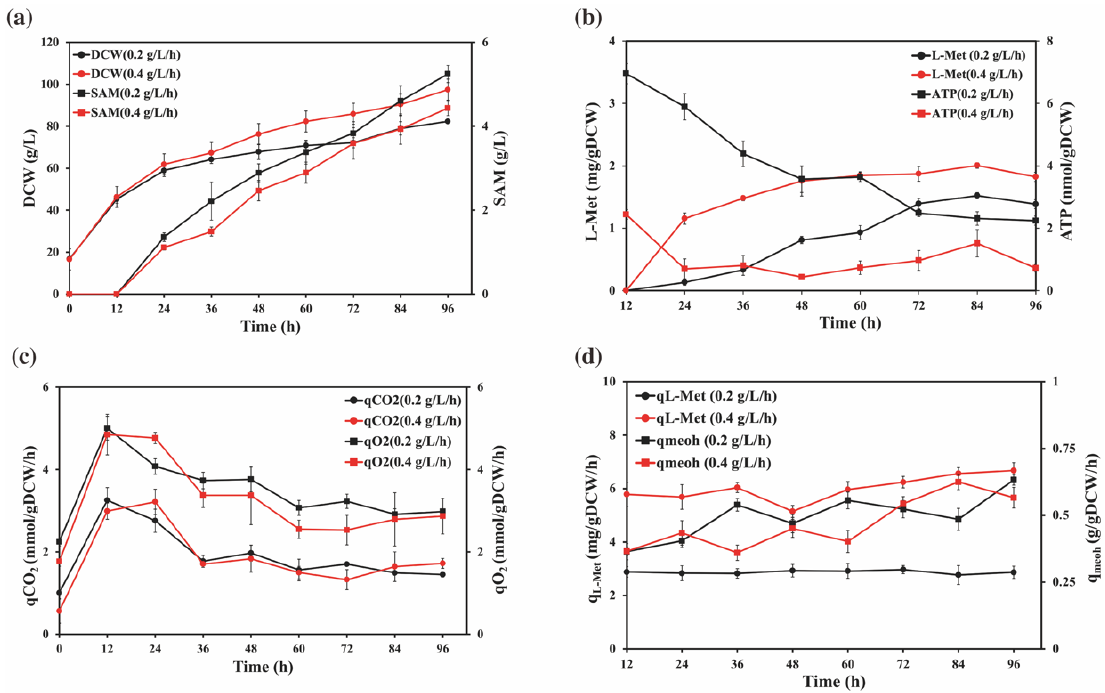
Figure 1. Physiological profiles of P. pastoris at the rate of 0.2 g/L/h and 0.4 g/L/h L-methionine supplementation in fed-batch cultivations. The parameters include ( a ) biomass and SAM amounts, ( b ) L-methionine and ATP levels, ( c ) specific CO 2 emission rate and specific O 2 uptake rate, and ( d ) specific L-methionine and methanol uptake rate. All parameters were measured based on at least triplicate measurements. The experiments were run in triplicates. The L-Met and ATP concentrations described in the figure are statistically significant.